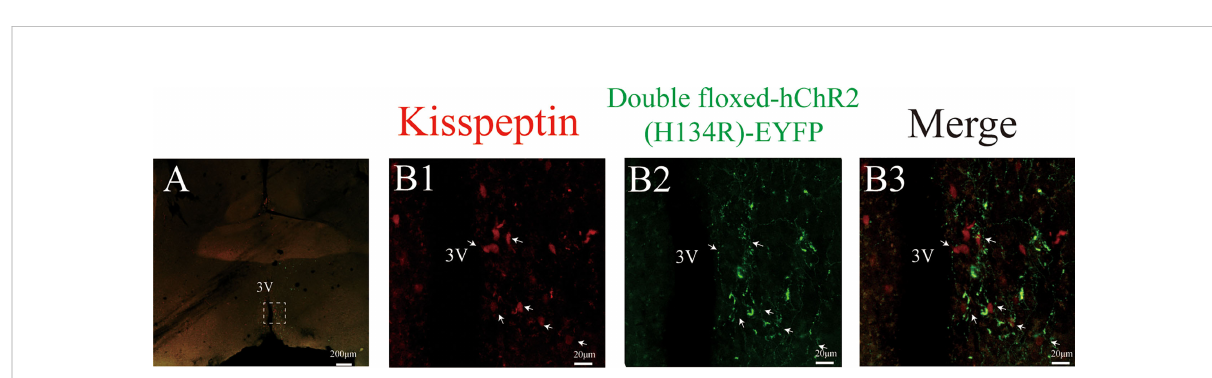
FIGURE 2 ExpressionChR2-EYFP ofKiss1 ARC projection terminals in AVPV (Kiss1 ARC ! AVPV ) of Kiss-Cre-tdTomato mice. (A) Shows the 4X magni fi cation ofAVPV area in Kiss1-tdTomato mice. (B1-B3) represents the magni fi ed area of the regionshown by the white box in A,illustratingthe Kiss1 AVPV neurons (red), Kiss1 ARC terminals in the AVPV regionwithChR2-EYFP expressionand co-localizationin the AVPV area (40Xmagni fi cation) respectively. The white arrow represents the somata of tdTomato-expressing Kiss1 AVPV neurons alongside the projections ofChR2-expressing Kiss1 ARC neurons (B3) .